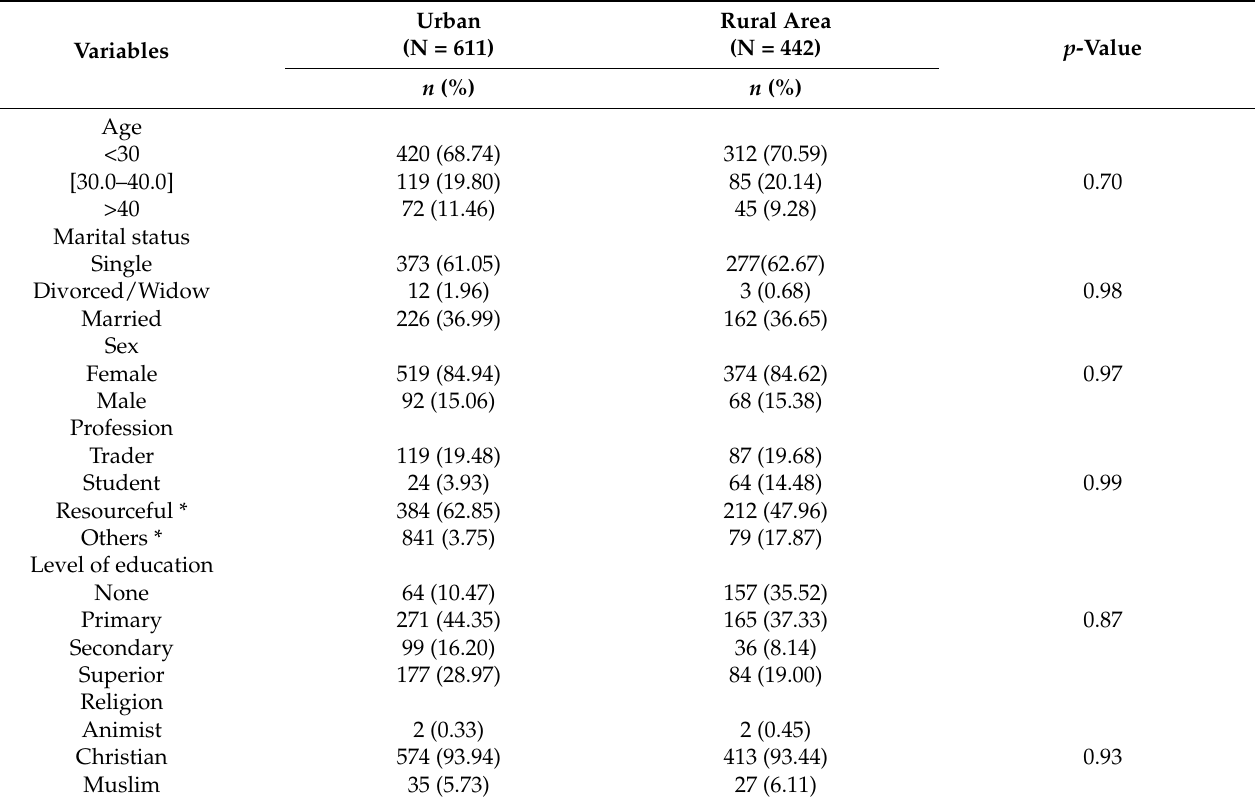
Table 1. Distribution of respondents according to their socio-demographic